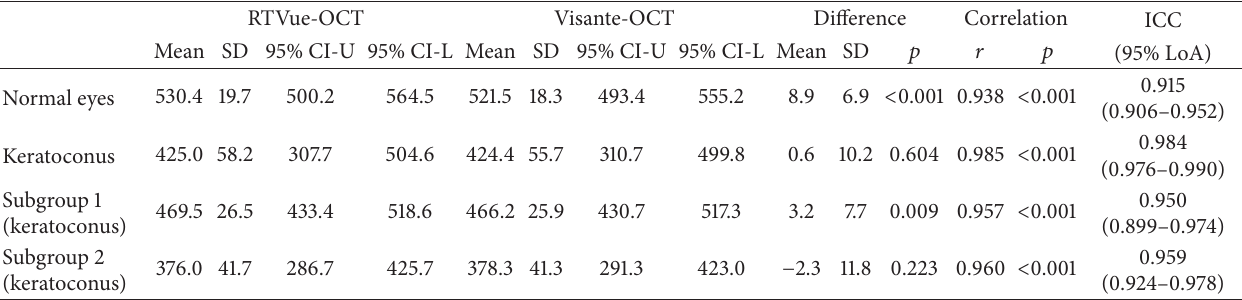
Table 1: Difference and correlation analysis of the TCT from the RTVue-OCT and Visante-OCT.